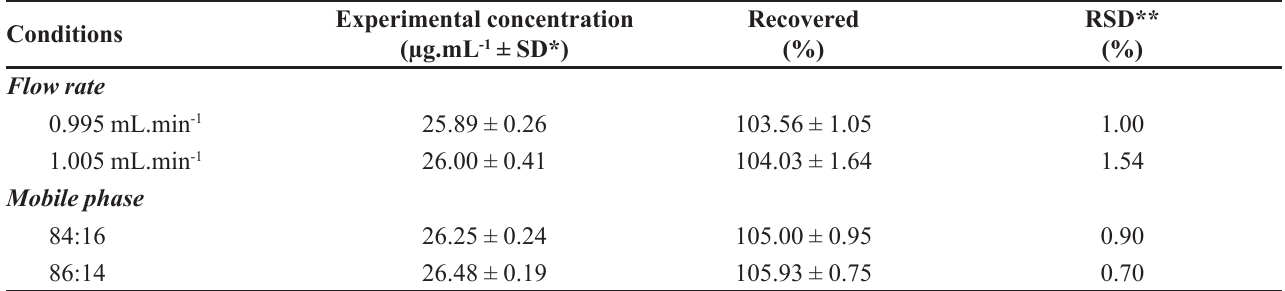
TABLE V - Robustness for halcinonide analysis Conditions